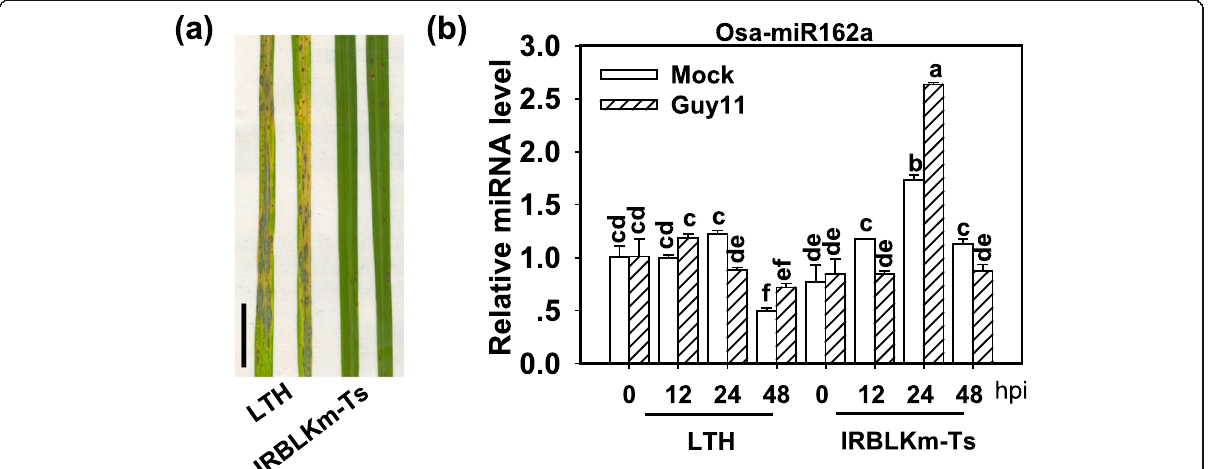
Fig. 1 Osa-miR162a is differentially responsive to Magnaporthe oryzae in the susceptible and resistance accessions. a Blast disease phenotype on leaves of susceptible accession LTH and resistant accession IRBLKm-Ts following spray-inoculation of Magnaporthe oryzae Guy11 (1 × 10 5 spore/ ml concentration) at 5 days post-inoculation (dpi). Scale bar =1 cm. b Accumulation of Osa-miR162a in indicated accessions with or without Guy11 infection. Total RNA was used to carry out reverse-transcription (RT) with an Osa-miR162 specific stem-loop RT primers (Additional file 4: Table S1), and the RT product was subsequently used as a template for quantitative polymerase chain reaction (q-PCR) to detect the amounts of Osa-miR162. snRNA U6 served as an internal reference. Error bars indicate SD. Different letters above the bars indicate a significant difference ( P < 0.05) as determined by a one-way ANOVA analysis. Similar results were obtained in at least two independent